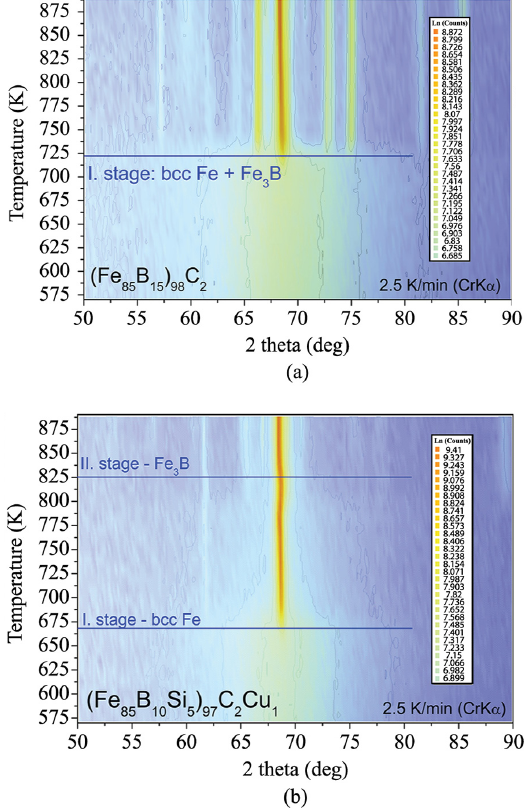
Figure 5. X-ray diffraction patterns - maps, by in-situ linear annealed samples, with marked phase evolution for sample based on: (a) Fe-B-C. (b)